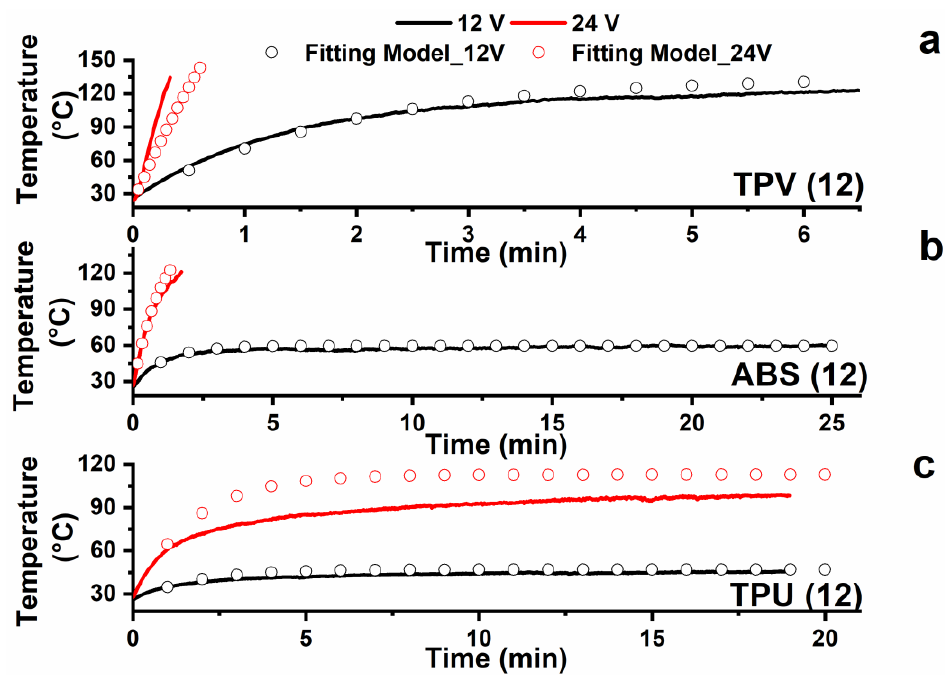
Figure 10. Comparison between experimental data (continuous curves) and analytical model (empty circles) of heating results detected at constant DC voltage on sheet-shaped specimens ( a ) TPV12; ( b ) ABS12; ( c ) TPU12.